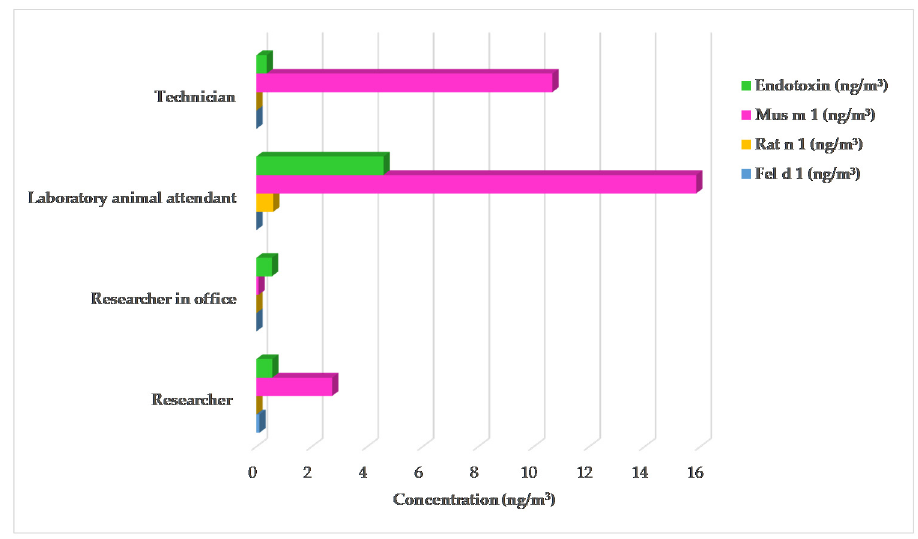
Figure 2. Average concentration of bio-contaminants distributed in the four work categories under investigation.